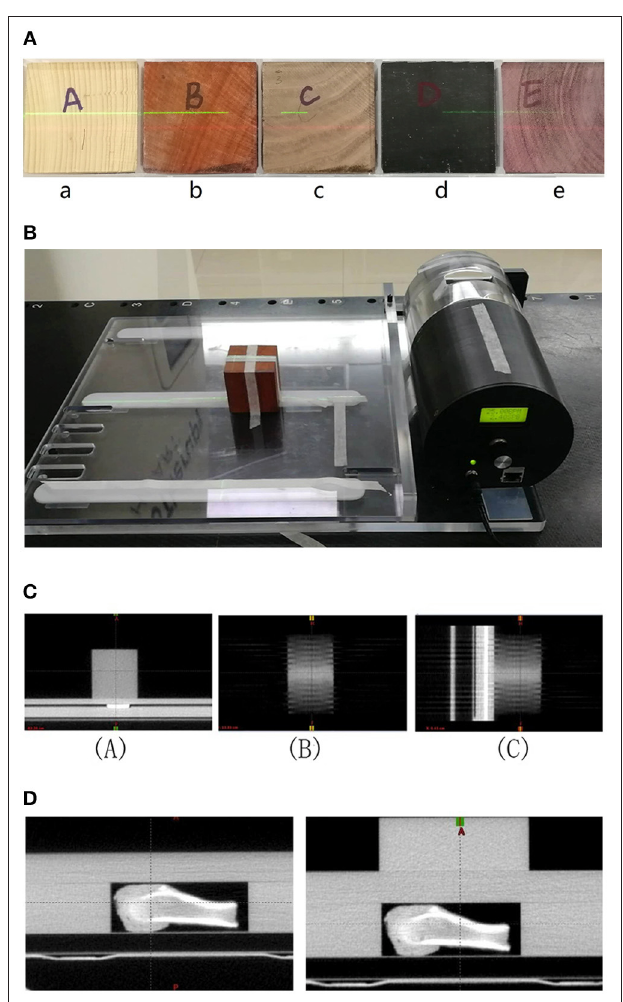
FIGURE 2 | (A) Part of the radiomics phantom including 4 blocks of wood (a, b, c, and e) and one block of rubber (d). (B) The dynamic motion phantom with one block of wood. (C) Images of wood in motion at 20 BPMs [(A): transversal, (B): frontal, and (C): sagittal]. (D) Images of bone surrounded by different thicknesses of solid